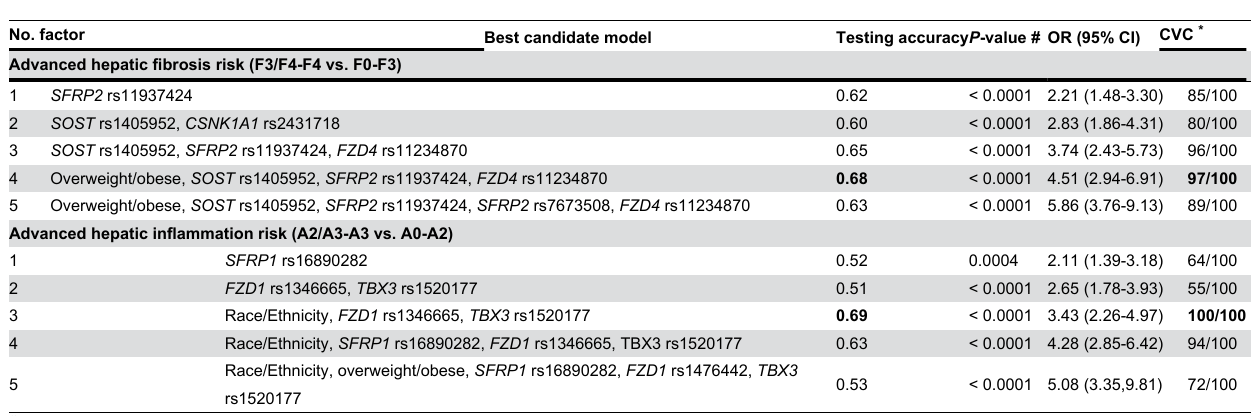
Table 5. Summary of Multifactor Dimensionality Reduction (MDR) results for interactions analysis on advanced hepatic fibrosis and inflammation